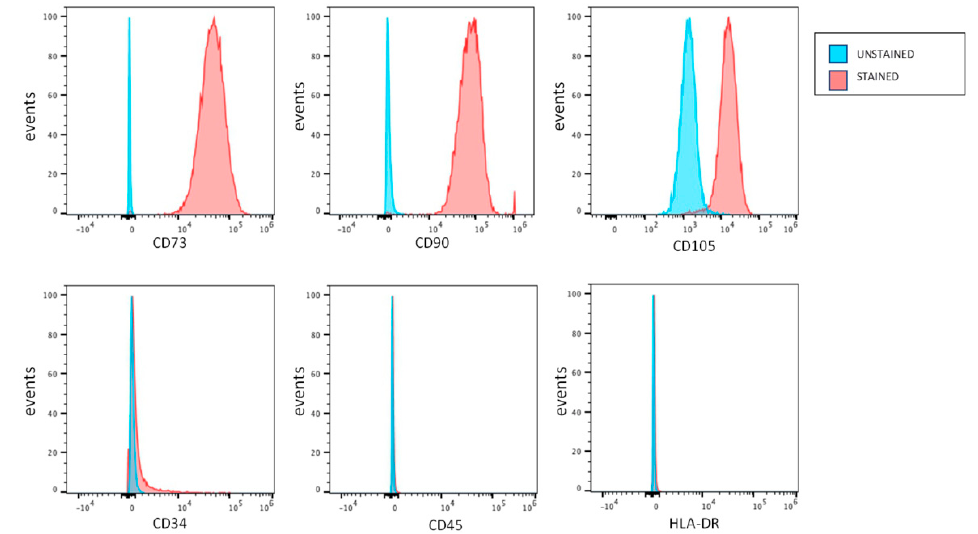
Figure 1. Immunophenotypic characterization of hDPSCs. Immunophenotypic characterization of c-Kit + /STRO-1 + hDPSCs by FACS analysis against mesenchymal surface antigens.